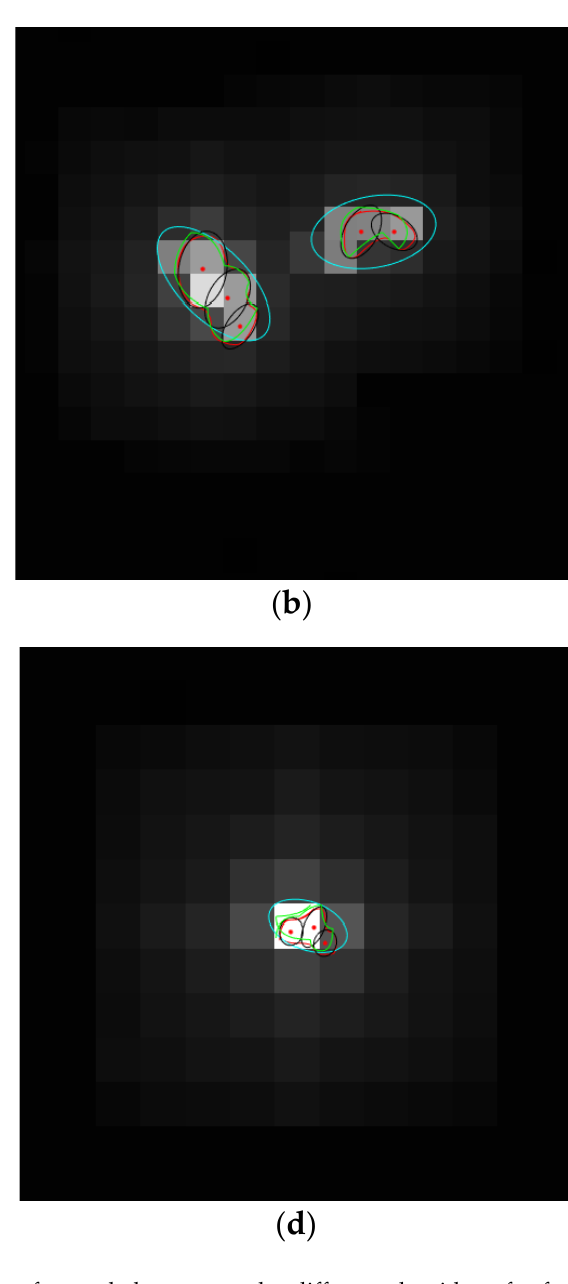
( a ) estimation of extension; ( b ) enlarged image of target 1 and target 2; ( c ) enlarged image of target 3;